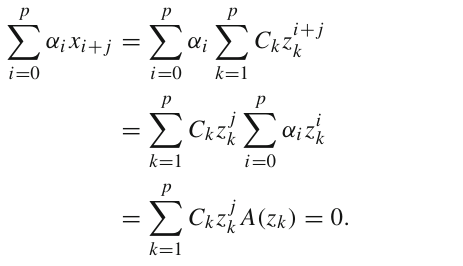
It is easy to find that A ( z i ) = 0 for any integer i from 1 to p